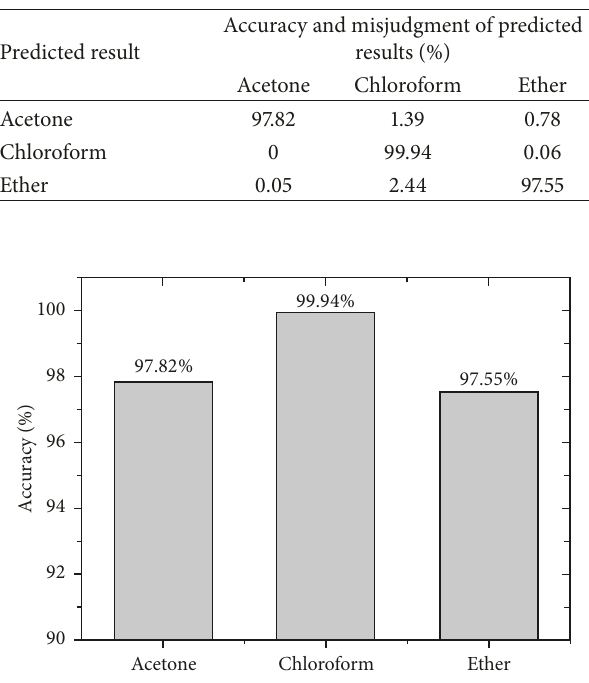
Figure 8: The classification accuracy of various molecules: acetone, chloroform, and